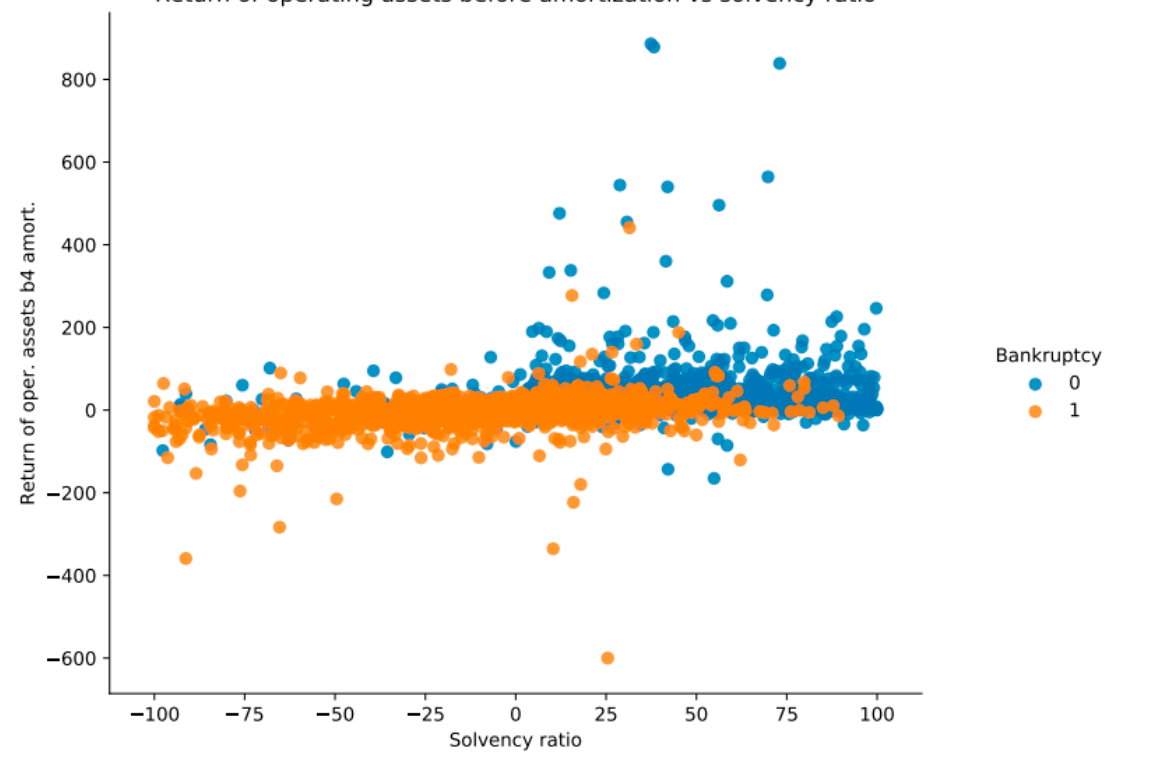
Figure 3. An illustration of the overlap between bankrupt cases in the profit first solvency space. The Receiver Operating Characteristics (ROC) curve is plotted with true positive rate (TPR) against the false positive rate (FPR) using the feedforward neural networks model